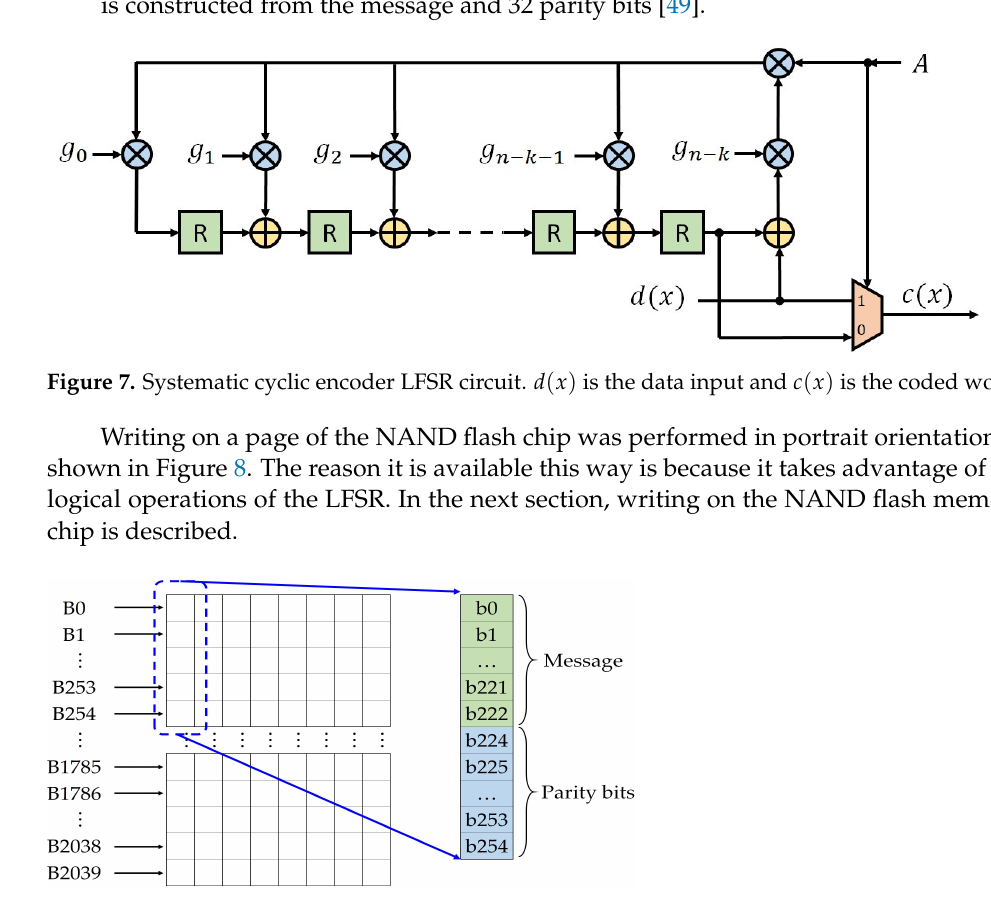
Figure 8. The orientation of each code was done vertically as shown. A byte has 8 bits, therefore the number of codes is